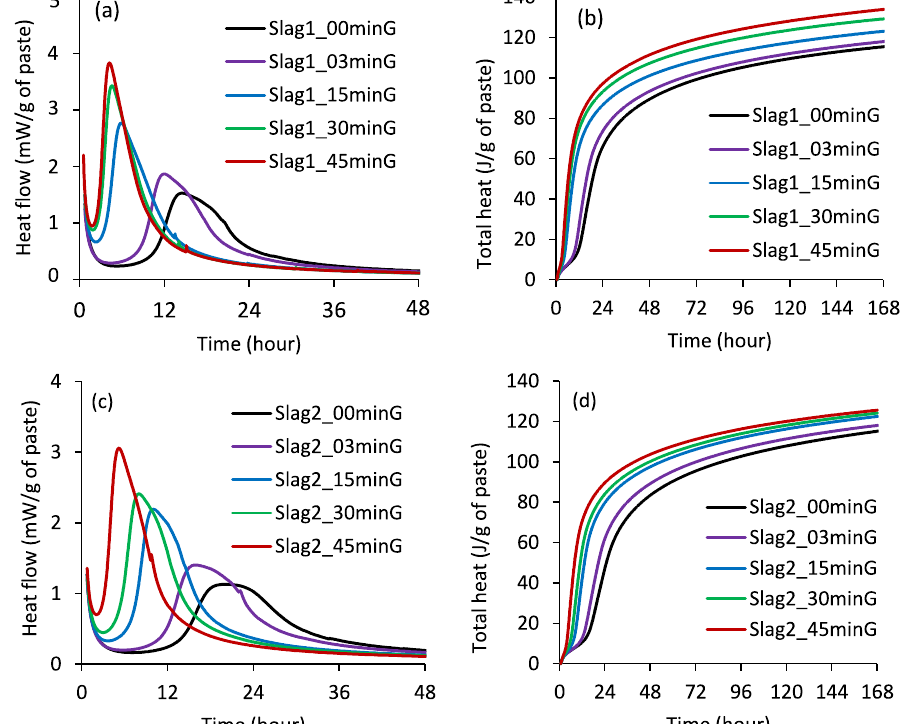
Figure 4. Isothermal calorimetry results of the activated samples: (a) and (c) are heat flow curves of the activated slag1 and slag2 samples, respectively, and (b) and (d) are the total heat of the activated slag1 and slag2 samples, respectively. All results are normalised per gram of